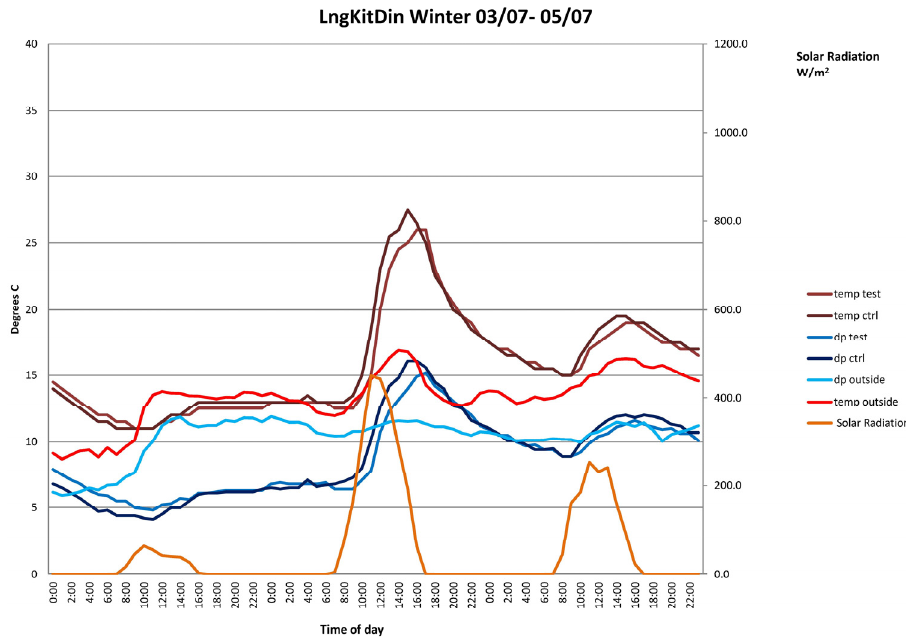
Figure 11. Temperatures and dew point comparisons for the lounge kitchen dining room with external winter conditions.